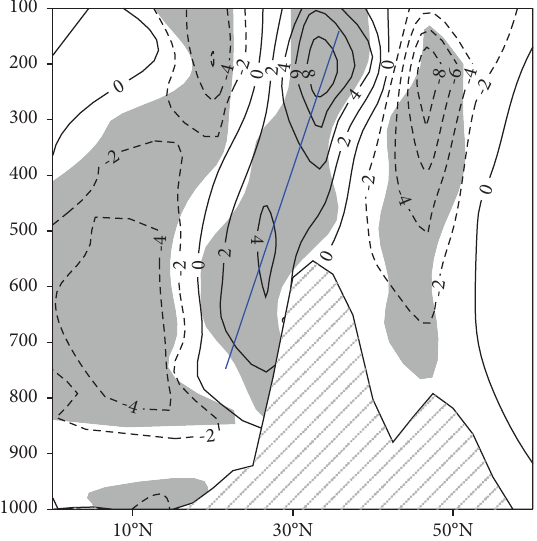
Figure 6: Diference synthetic feld of the height-latitude section of zonal wind along 97.5 ° E of strong AHS/weak westerly-monsoon year and weak AHS/strong westerly-monsoon year (unit: m/s, shadow indicates passing 95% reliability signifcance test, slashes area represent terrain).